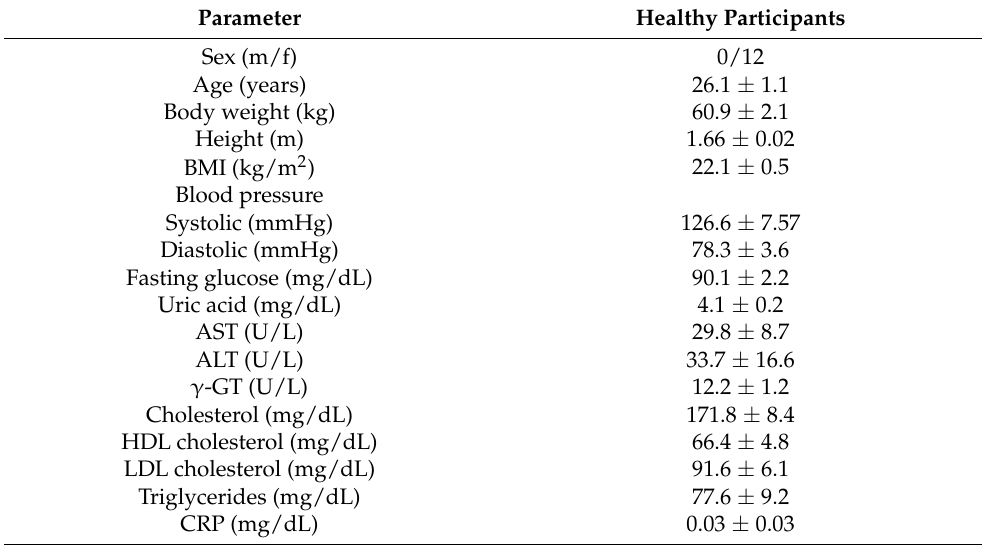
Table 1. Anthropometric and health characteristics of study participants. Data are expressed as means ± SEM. AST, aspartate amino transferase; ALT, alanine amino transferase; CRP, c reactive protein; γ -GT, γ -glutamyltransferase; HDL, high density lipoprotein; and LDL, low density